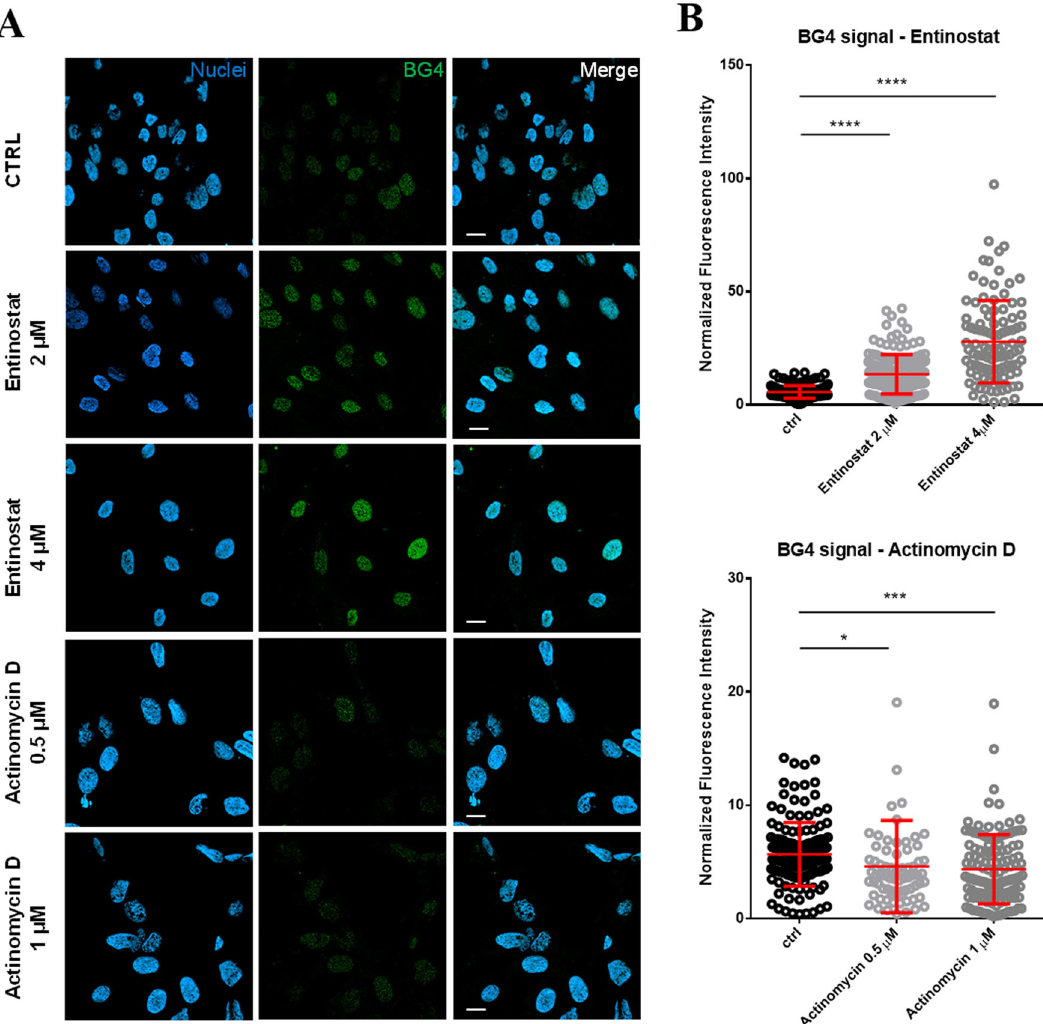
Fig. 3 Detection of G4s foci upon transcription perturbation treatments. A Representative fi elds of view showing G4 foci formation detected by immuno fl uorescence in control non-treated (CTRL), entinostat (2 and 4 μ M) and actinomycin D (0.5 and 1 μ M) treated 93T449 cells. Nuclear staining (blue), BG4 (green), and the merged channels are reported. Scale bars = 20 μ m. The shown fi elds belong to one of two independent biological replicates. B Quanti fi cation of BG4 nuclear staining detected by immuno fl uorescence in control non-treated and entinostat (2 and 4 μ M) — upper panel — or actinomycin D (0.5 and 1 μ M) treated — lower panel. BG4 integrated fl uorescence intensity within nuclei normalized by the corresponding nuclear area ( μ m 2 ) is reported. The central line for each condition represents the mean ± standard deviation. Statistical signi fi cance was calculated by unpaired two- sided T test (CI 95%) with: **** p value < 0.0001, *** p value < 0.001, * p value < 0.01. Exact p values are the following: actinomycine D 0.5 μ M p =